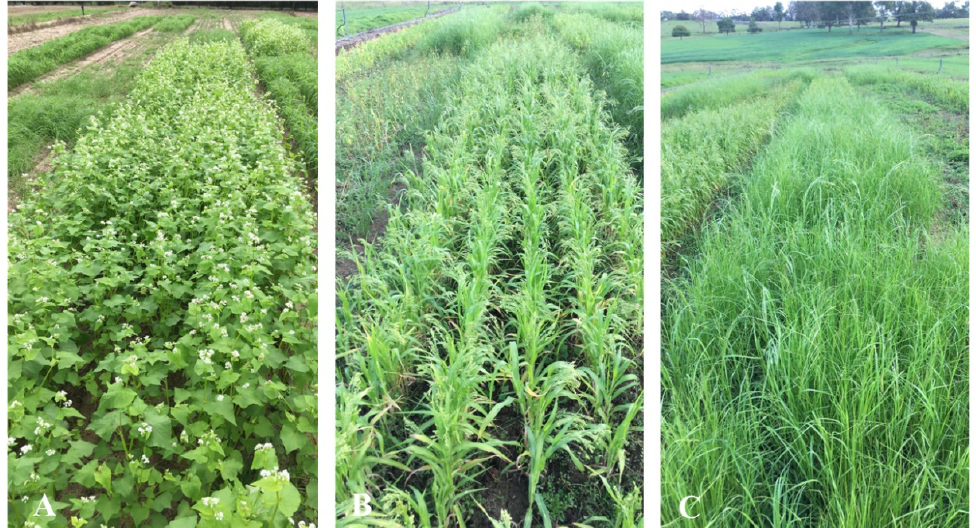
Figure 1. The three cover crop species grown in field trials at Lansdowne and Bringelly: ( A ) buck- wheat, ( B ) white French millet and ( C ) teff.